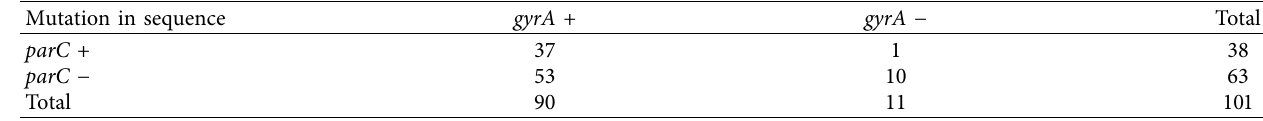
Table 2: Summary of mutation analysis in parC and gyrA